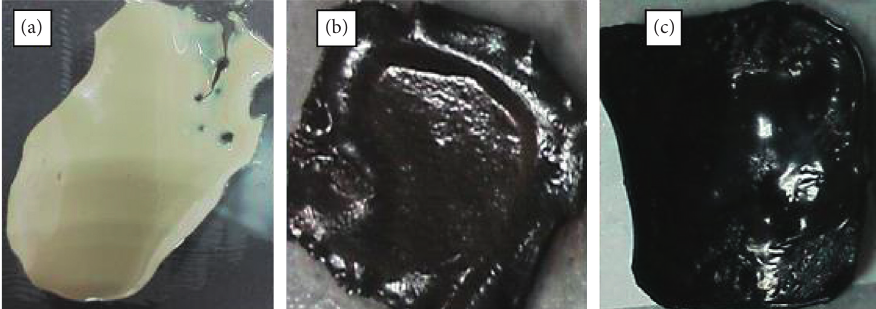
Figure 5: Knife cast wet phase inversion membranes of (a) Poly(amic) acid solution (b) Silver nanoassisted Poly(amic) acid membrane (c) Silver/Gold Nanoassisted Poly(amic) acid membrane. Actual sizes of pictured membranes are 3.5 ± 0.5cm.